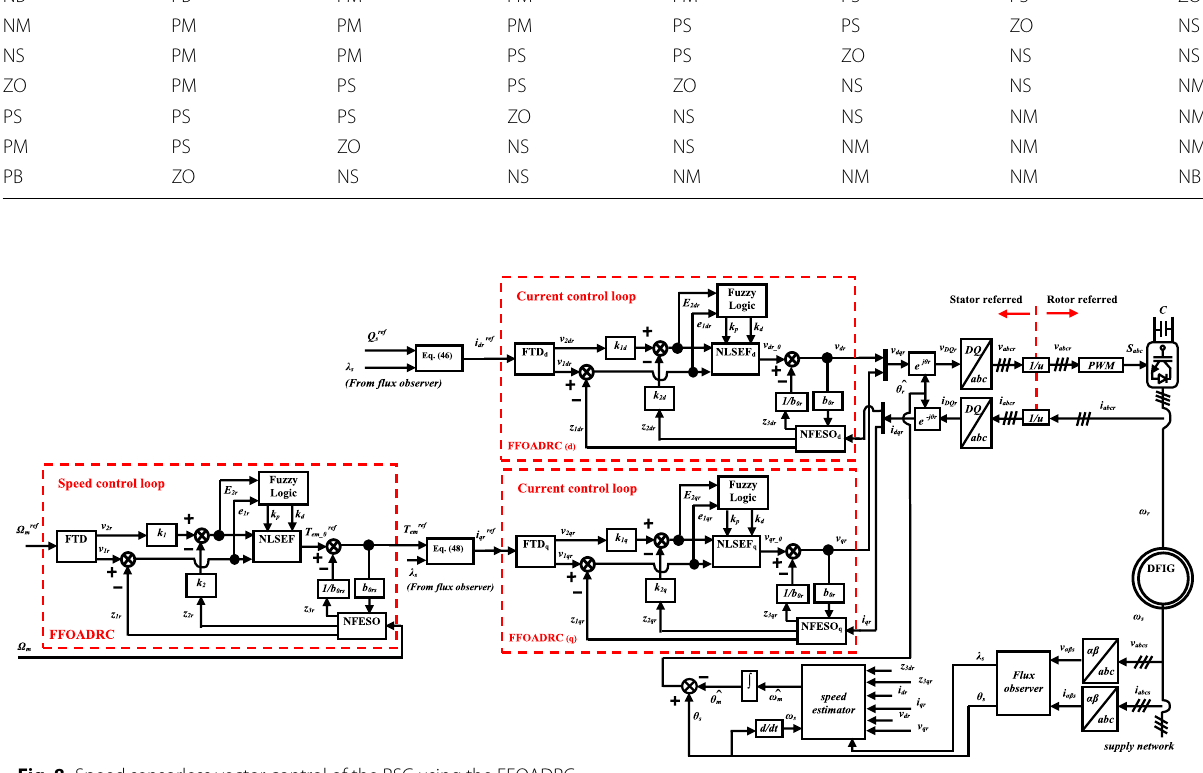
Fig. 8 Speed sensorless vector control of the RSC using the